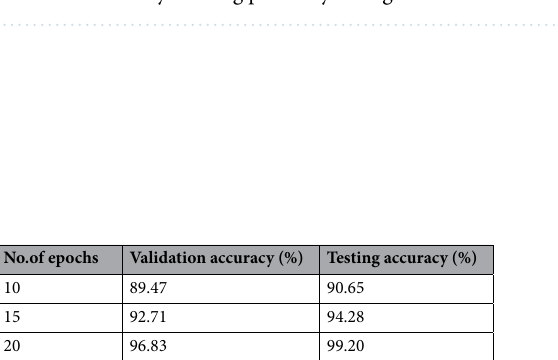
Table 1. Accuracy for lung parenchyma segmentation with different epochs.